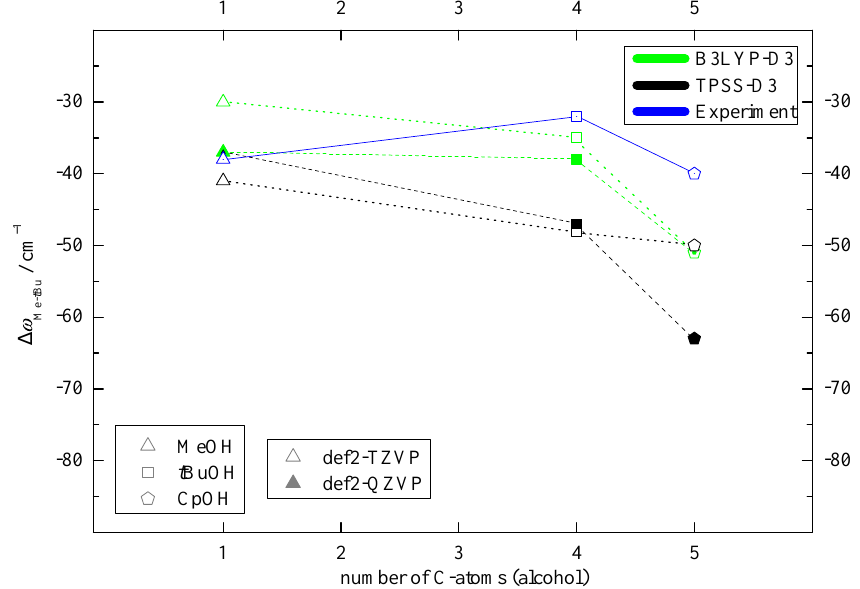
Figure 3. Computed OH wavenumber difference between the two docking sides ∆ ω Me − t Bu relative to the number of C-atoms of the corresponding alcohol. This shows that the employed computational methods predict the same spectral trends for MeOH and t BuOH, indicated by dashed lines. For CpOH a somewhat larger discrepancy can be observed, with the smaller basis set TPSS result differing most from the experimental trend (blue) (see Table S4 for